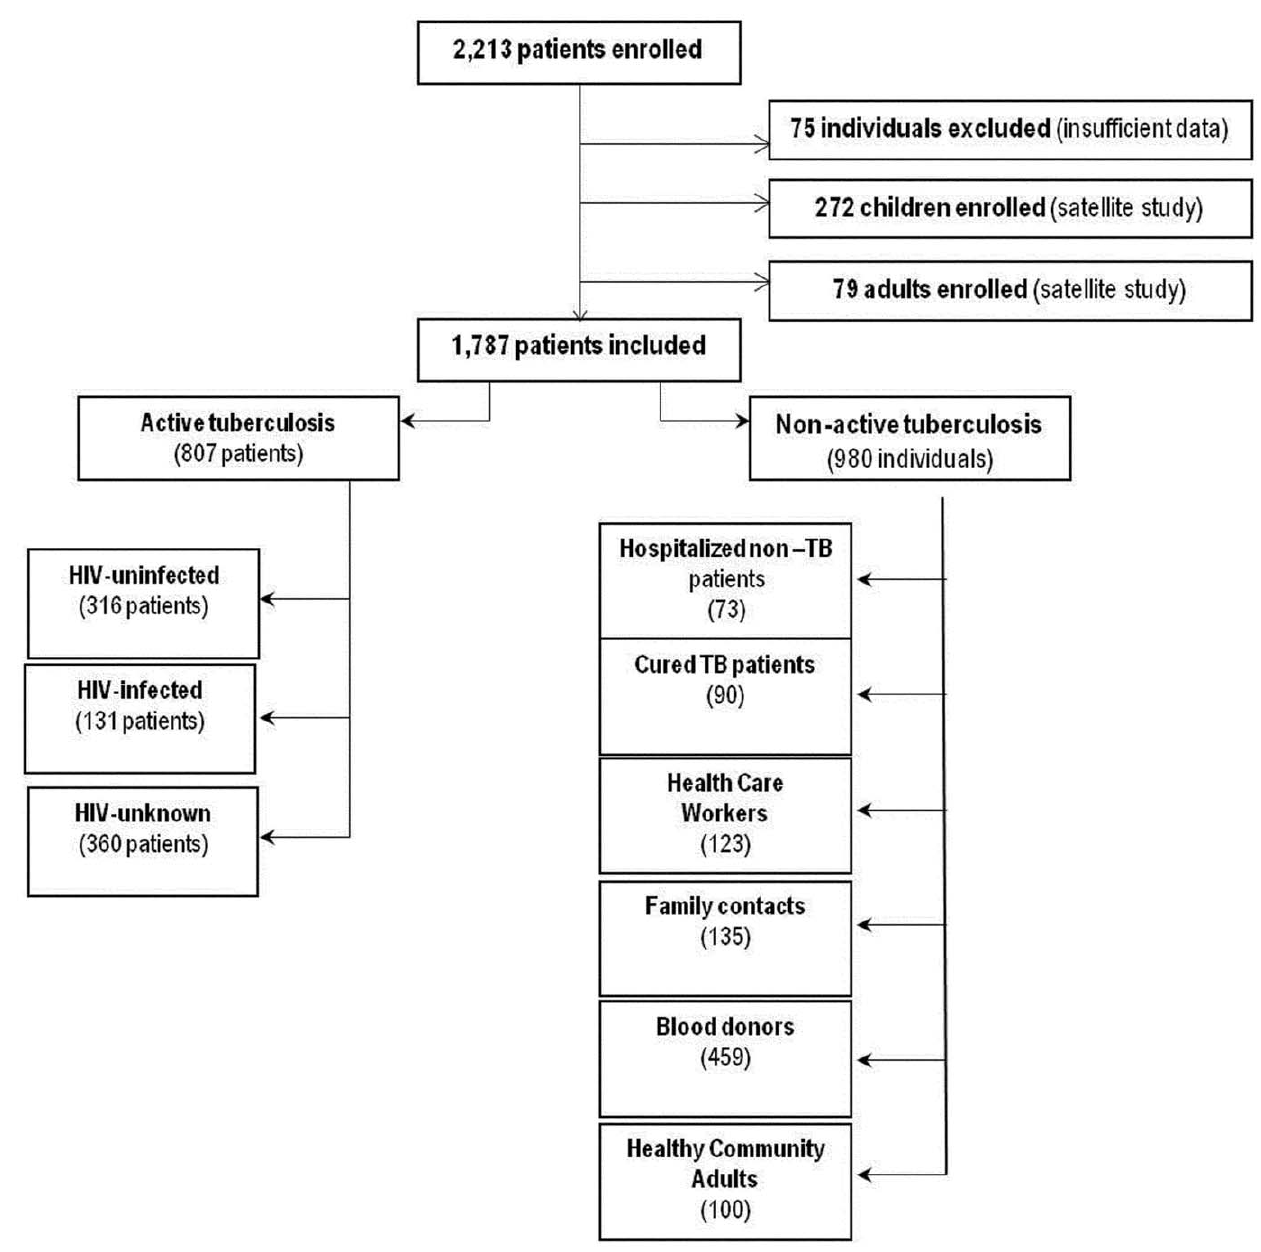
Figure 1. Flow chart of patients recruited to the multicentric study stratified by patient subgroups.